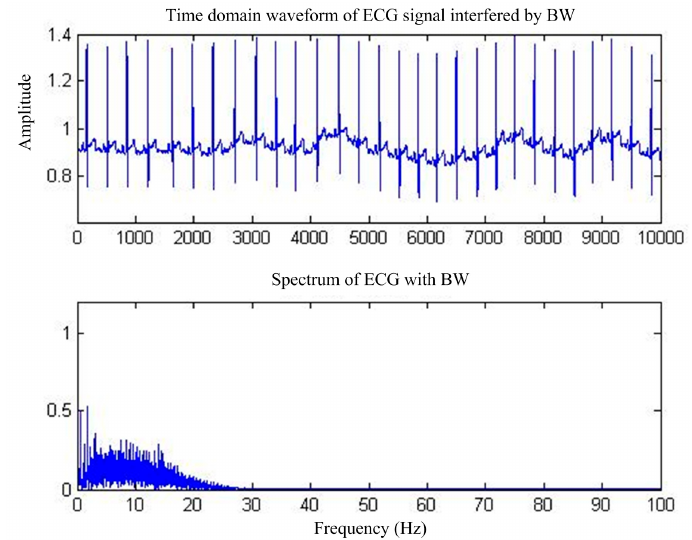
Figure 2. ECG signals under BW interference.